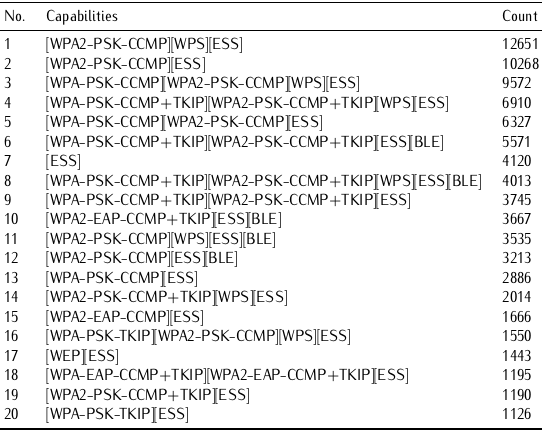
Figure 3. All-time data comparison between Romania security and World security